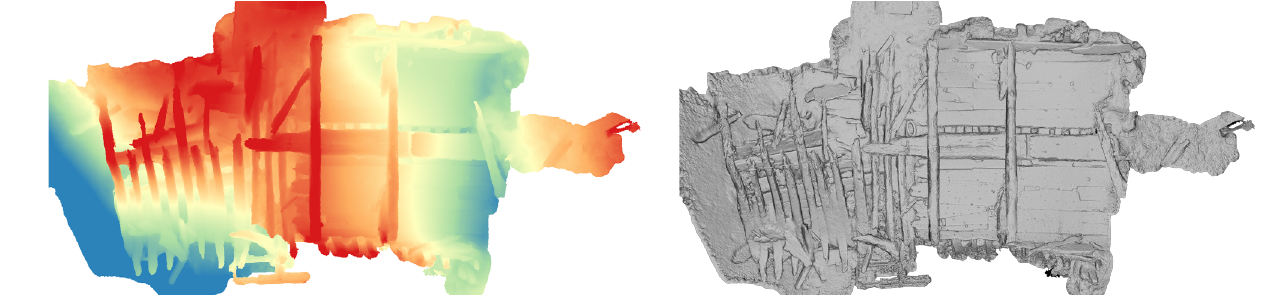
Figure 3. Surface mesh of the Straatvaarder wreck,